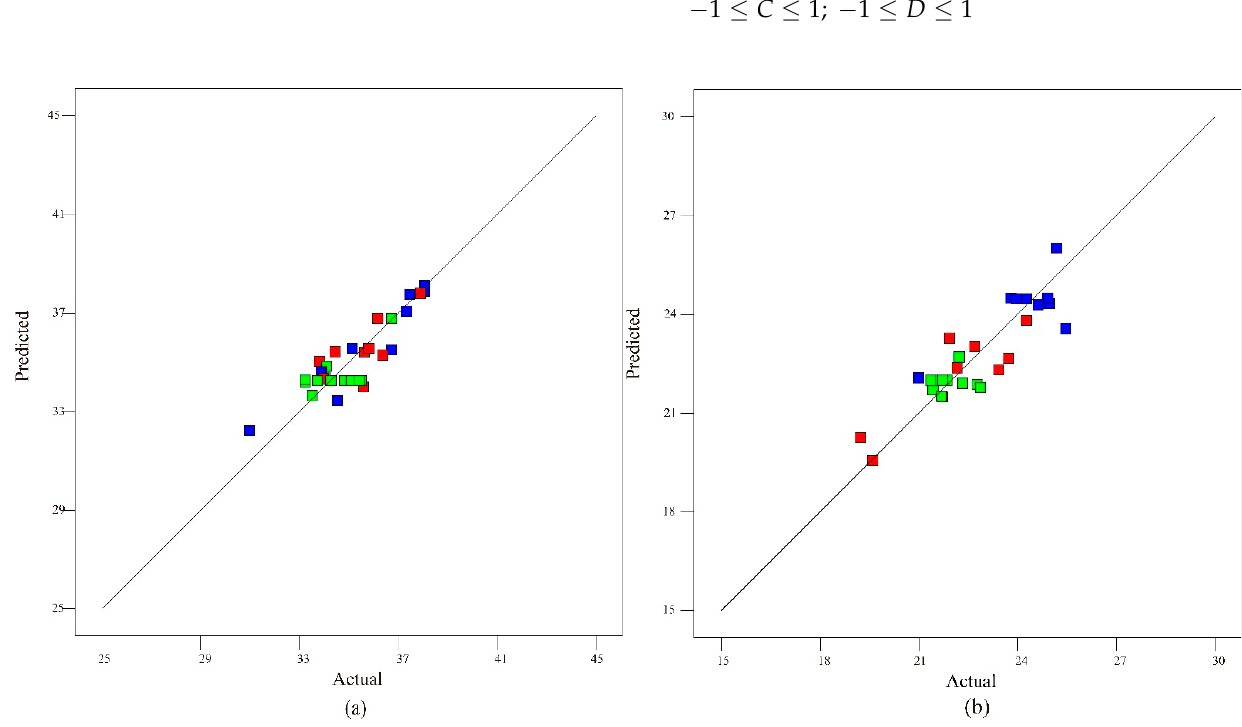
Figure 8. Predicted and actual value for mechanical strength: ( a ) tensile; ( b ) compressive.